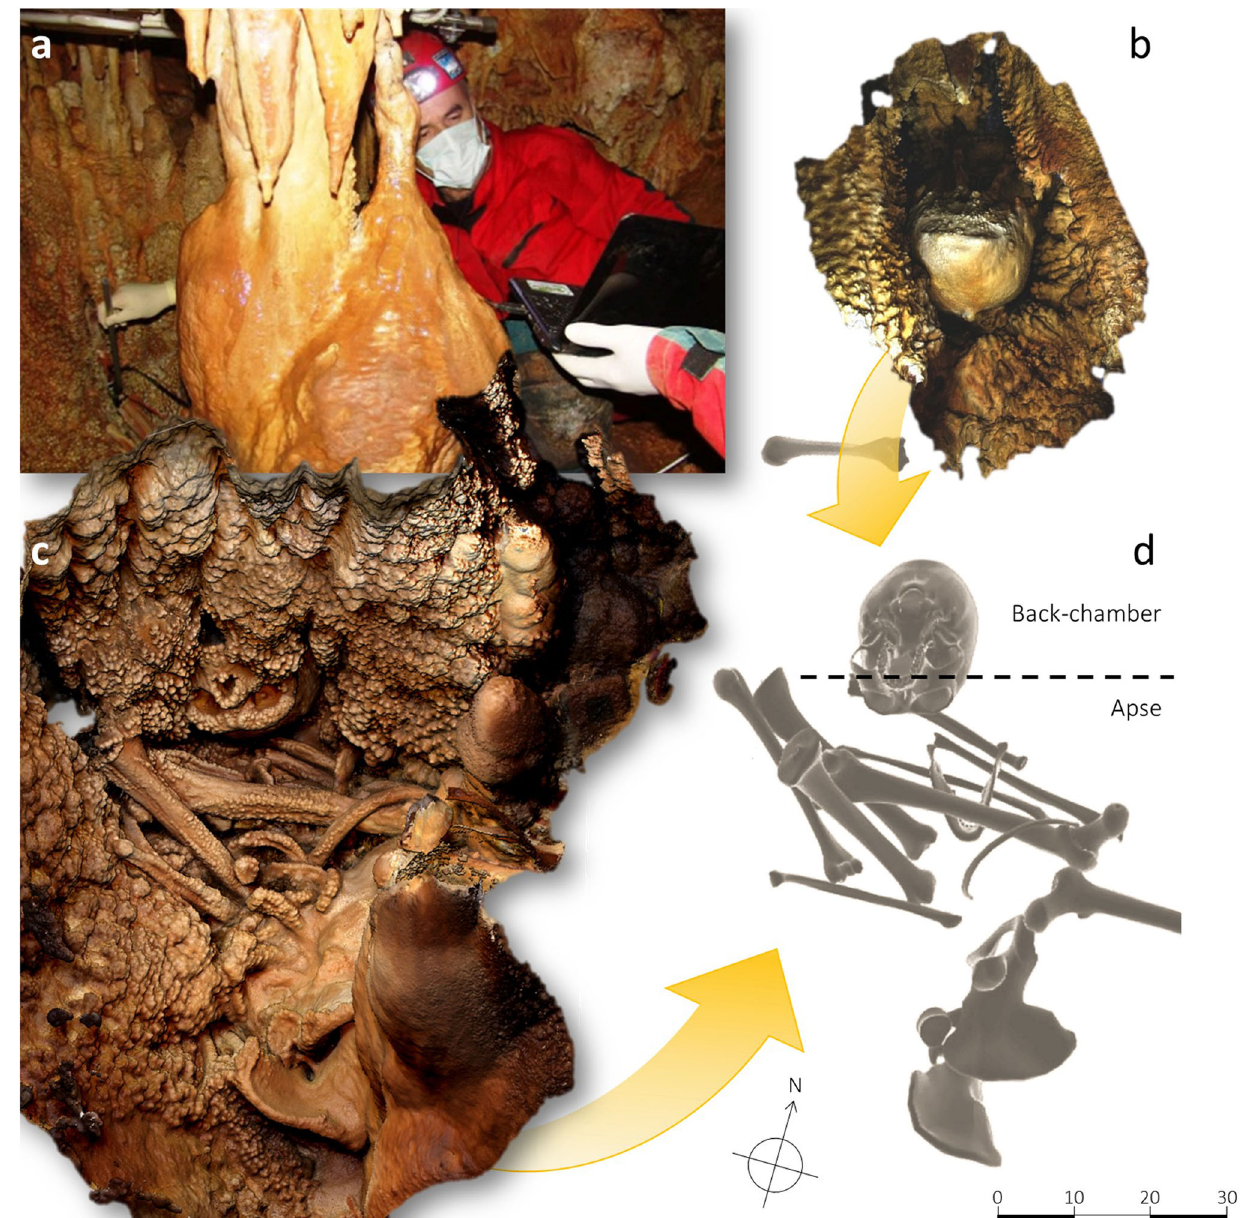
Fig. 1 The Altamura cranium straddles two chambers within the karstic system. Photographic probes ( a ) were used to acquire photogrammetrically the basal and posterior components (BP) of the cranium ( b ), exposed in the Back-chamber. Its frontal and facial parts (FF) were acquired by laser scanner from the Apse ( c ), where also the mandible and several long bones are directly visible on the cave fl oor ( c , d